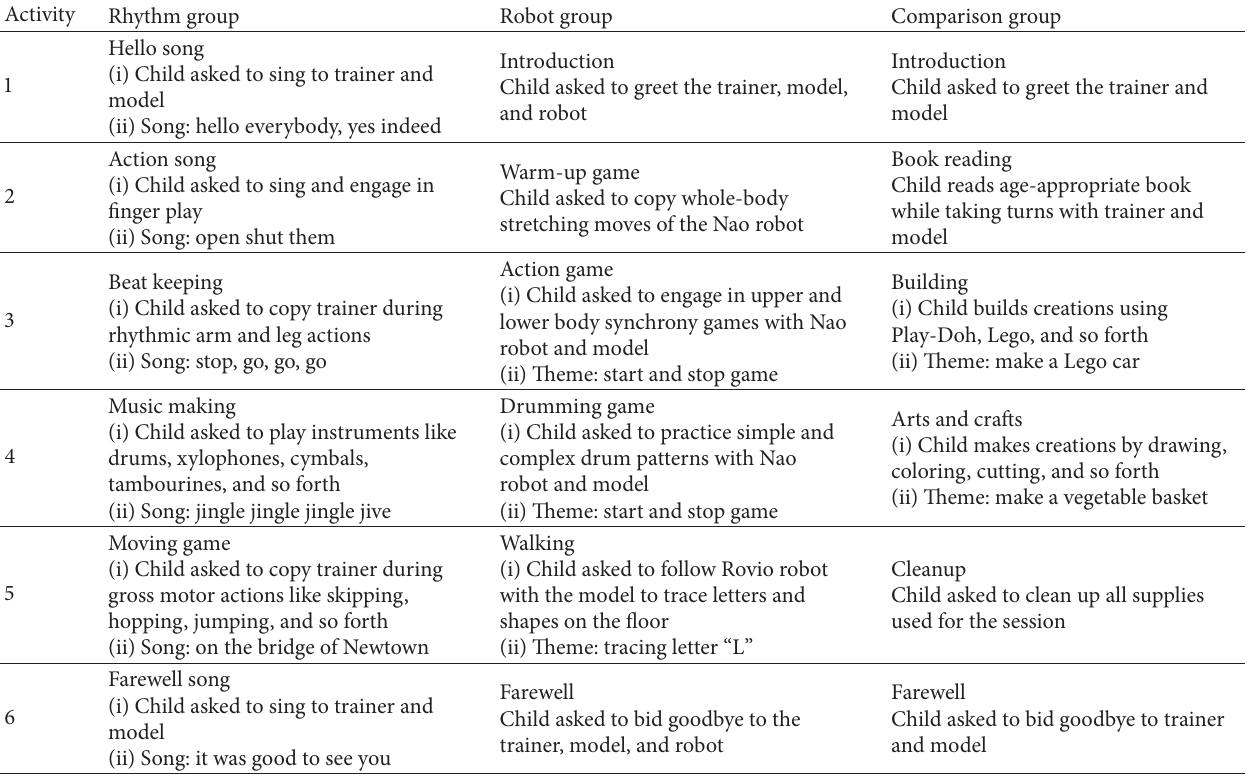
Table 5: An exemplar rhythm, robot, and comparison group training session.